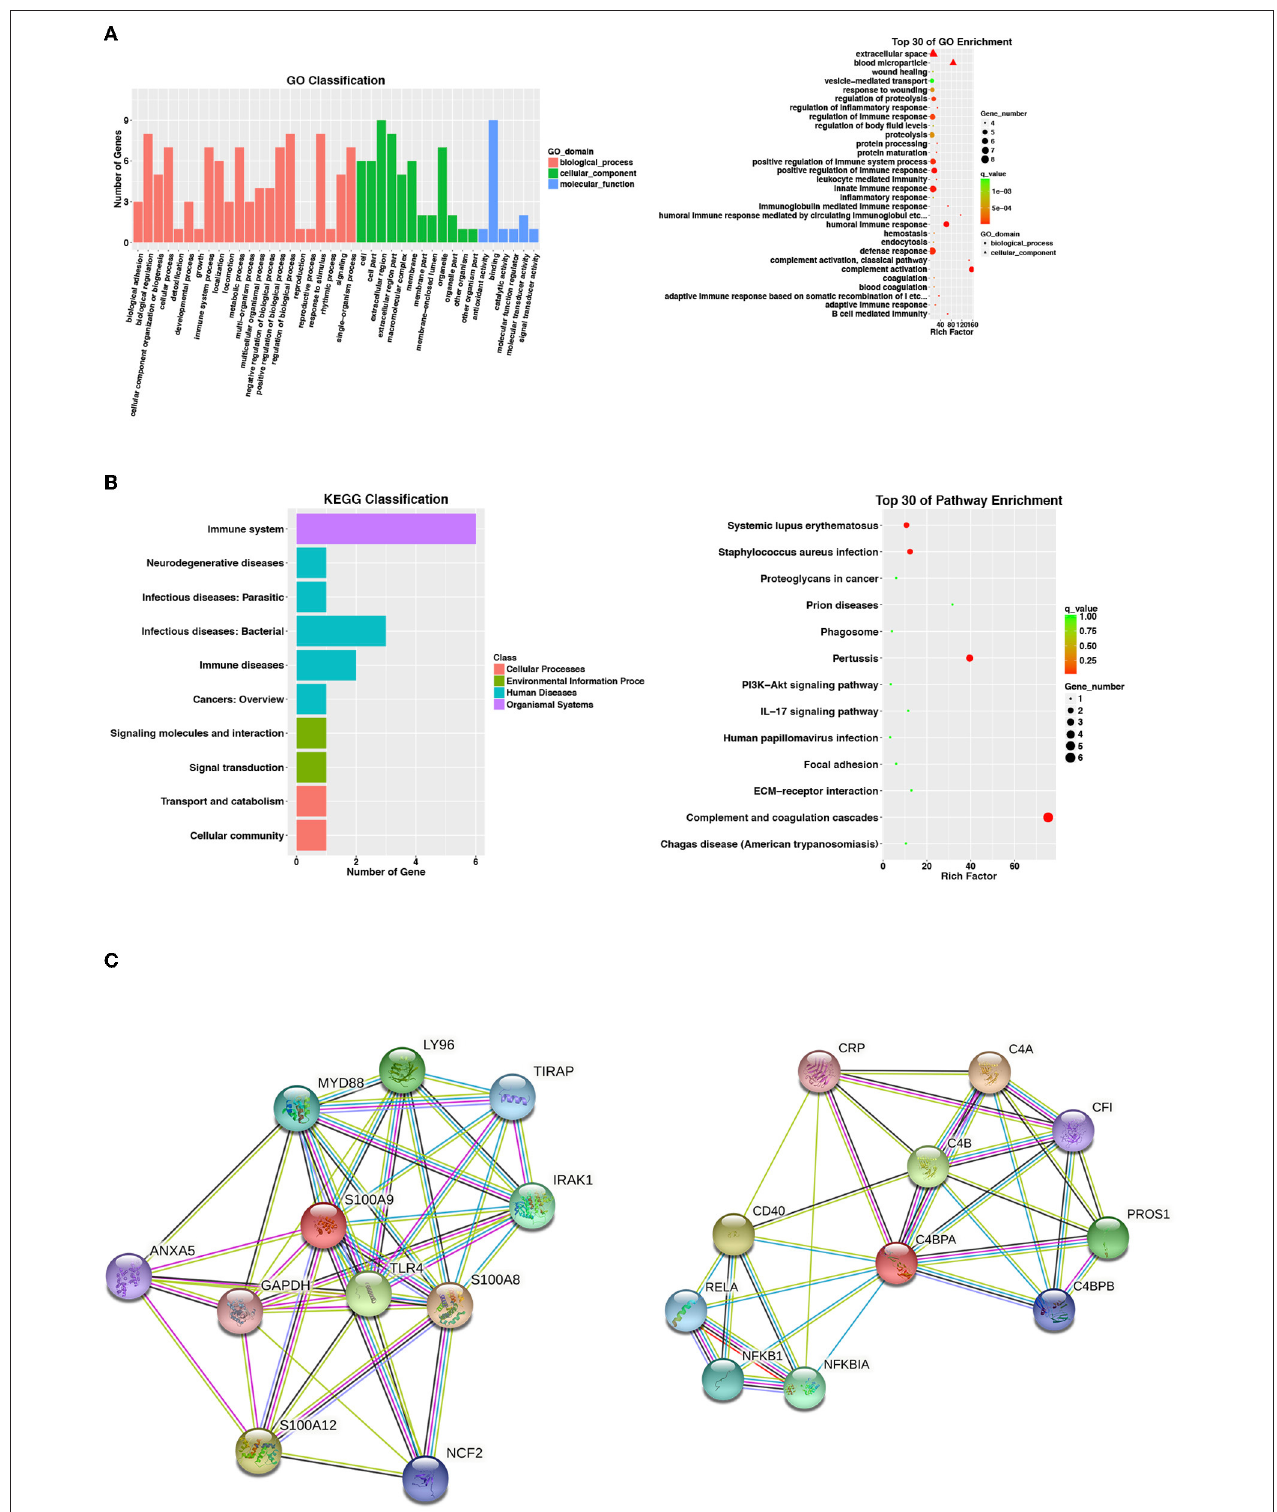
FIGURE 2 | Proteomic analysis of nine identified differentially expressed proteins. For the two analyses of (A,B) , selecting no more than 30 items with the smallest p -value to draw the bar plot and dot plot, respectively. (A) Go enrichment analysis by biological process, cell component, and molecular function for 9 identified differentially expressed proteins. Bar chart showing the significant proteins involved in the distribution of biological process (BP), cellular component (CC), and